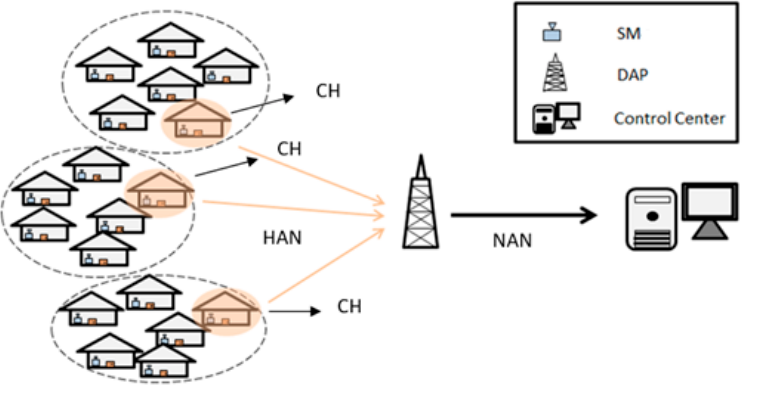
Figure 1. The smart grid system model.